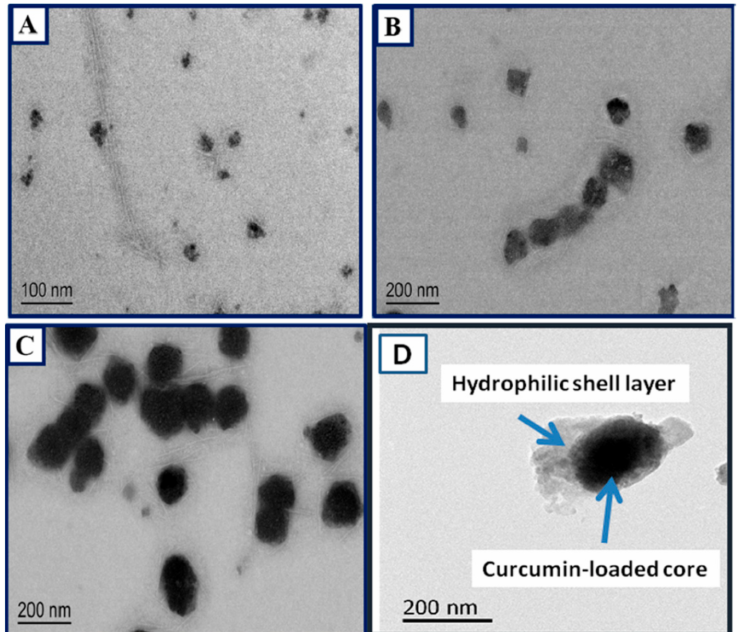
Figure 18. TEM images of untreated ( A ) and re-assembled β -CG before ( B ) and after loading curcumin ( C , D ) shows the core-shell formation of the nanoparticles. Reprinted with permission from ref. [114]. Copyright 2019 American Chemical Society.